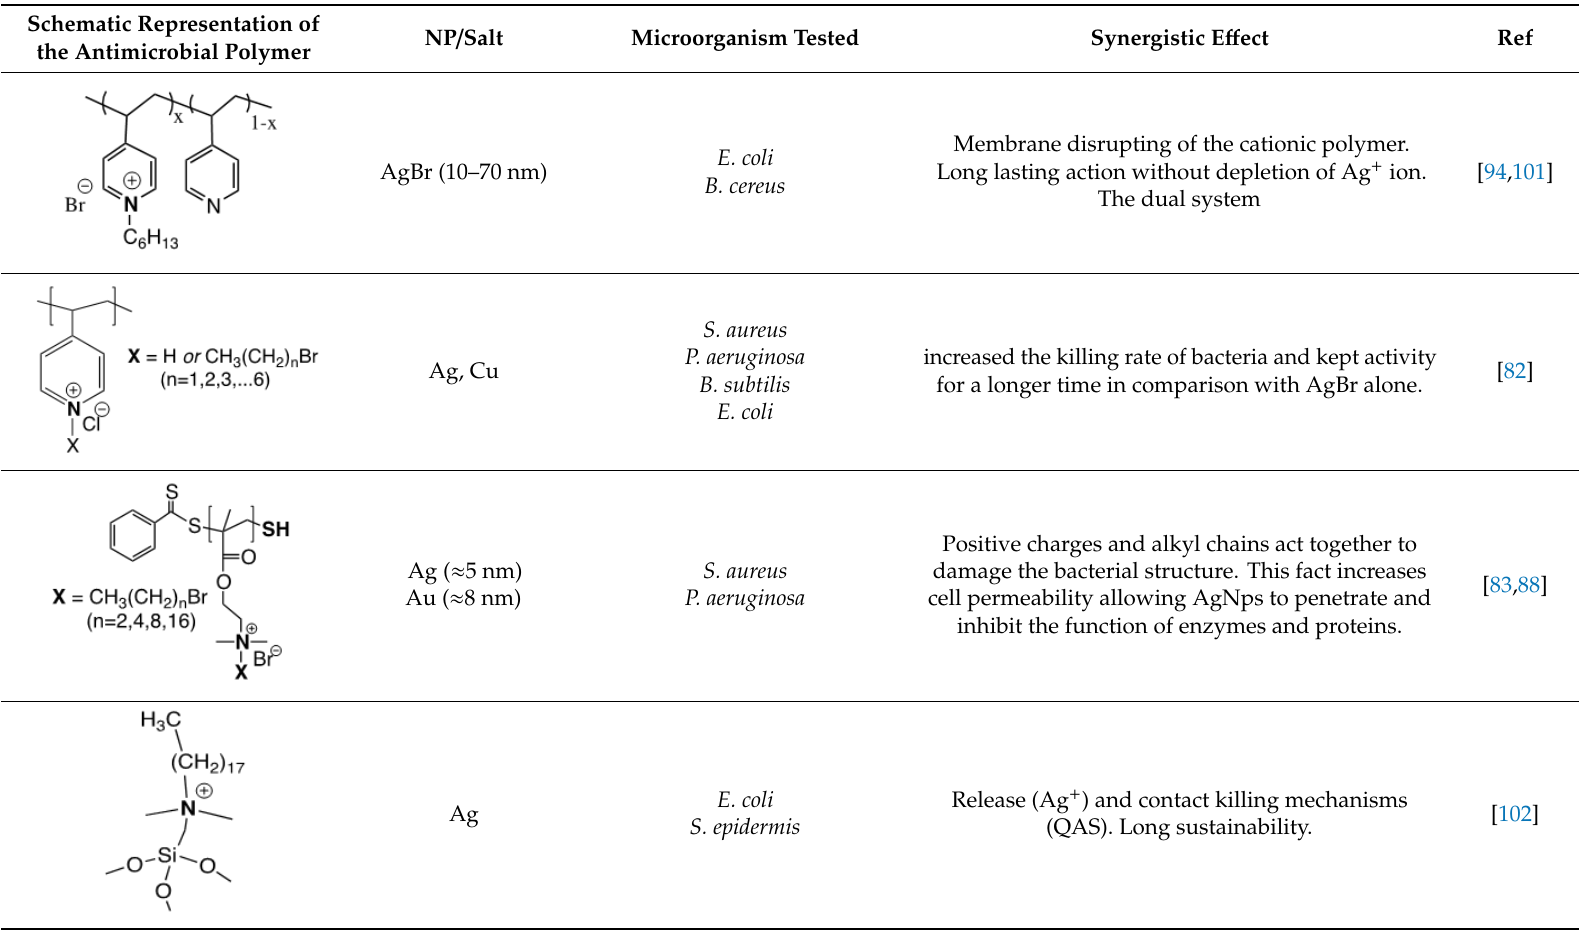
Table 2. Mechanisms of action of dual antimicrobial systems based in synthetic cationic polymers and metallic nanoparticles (NPs). Schematic Representation of